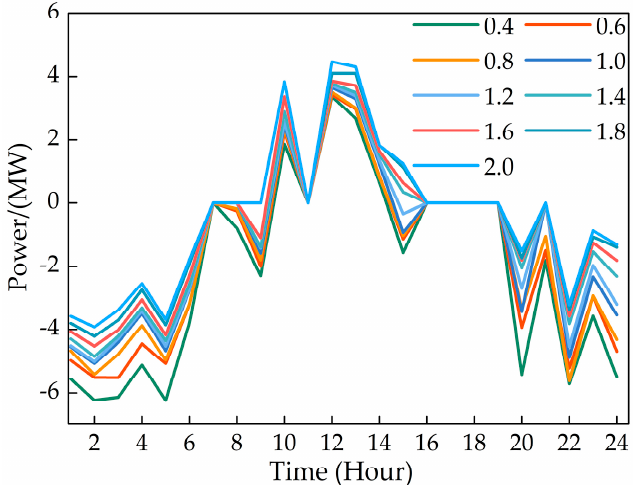
Figure 12. Bidding curve of the VPP in the DA market under different risk preference coefficients of the DA market.